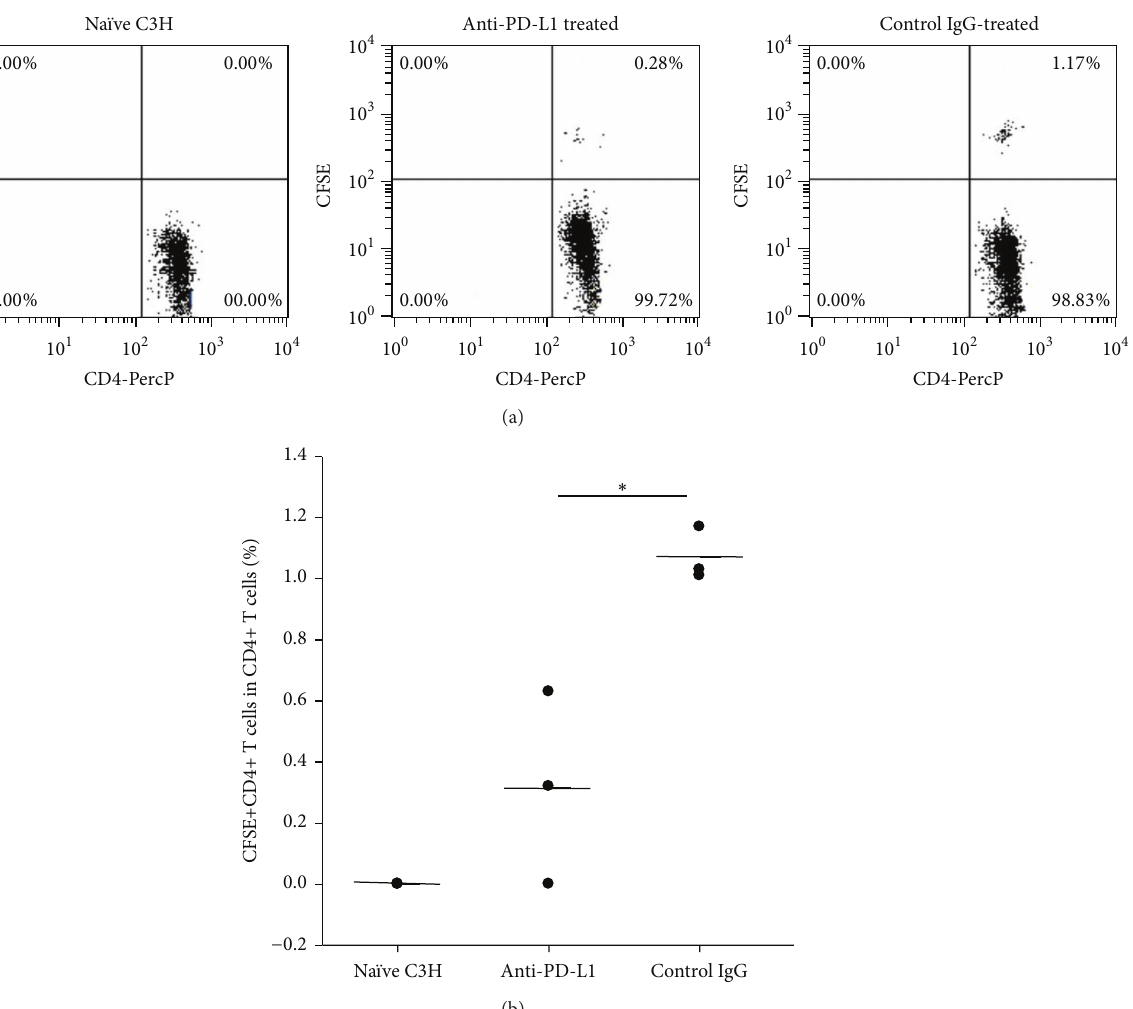
Figure 4: Anti-mouse PD-L1 antibody treatment enhances the rejection of intravenously injected Balb/c spleen cells in C3H mice with long- lasting tolerance. The tolerant C3H mice received purified anti-mouse PD-L1 mAb (100 𝜇 g/mouse) or control IgG (100 𝜇 g/mouse) along with administration of CFSE-labeled Balb/c spleen cells (1.5 × 10 7 /mouse). Nontolerant C3H mice received the same numbers of CFSE-labeled Balb/c spleen cells as control. Three mice were included in each group. 24 hours after injection, peripheral blood samples were collected from all mice and stained with anti-CD4-PercP antibody. The CFSE+CD4+ cells to total CD4+ T cells were examined by flow cytometry. (a) Flow cytometric data are exhibited from a representative mouse of each group. (b) The data summary of all mice in each group is depicted. Data represent mean ± standard error. ∗ 𝑃 < 0.05 . The 𝑃 values were calculated using one-way